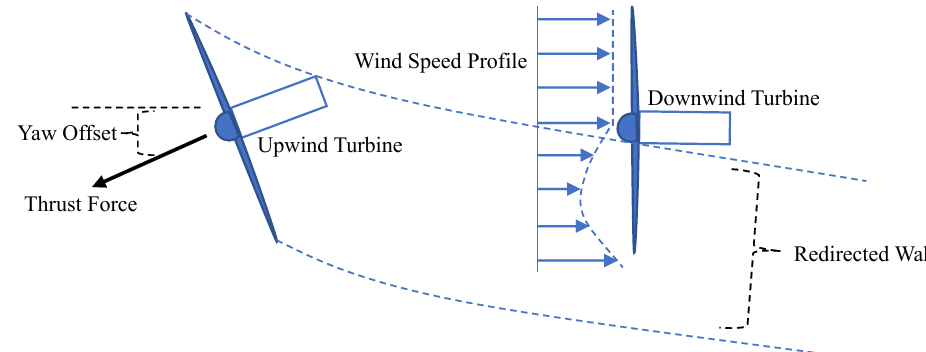
Figure 11. Schematic representation of wake redirection control